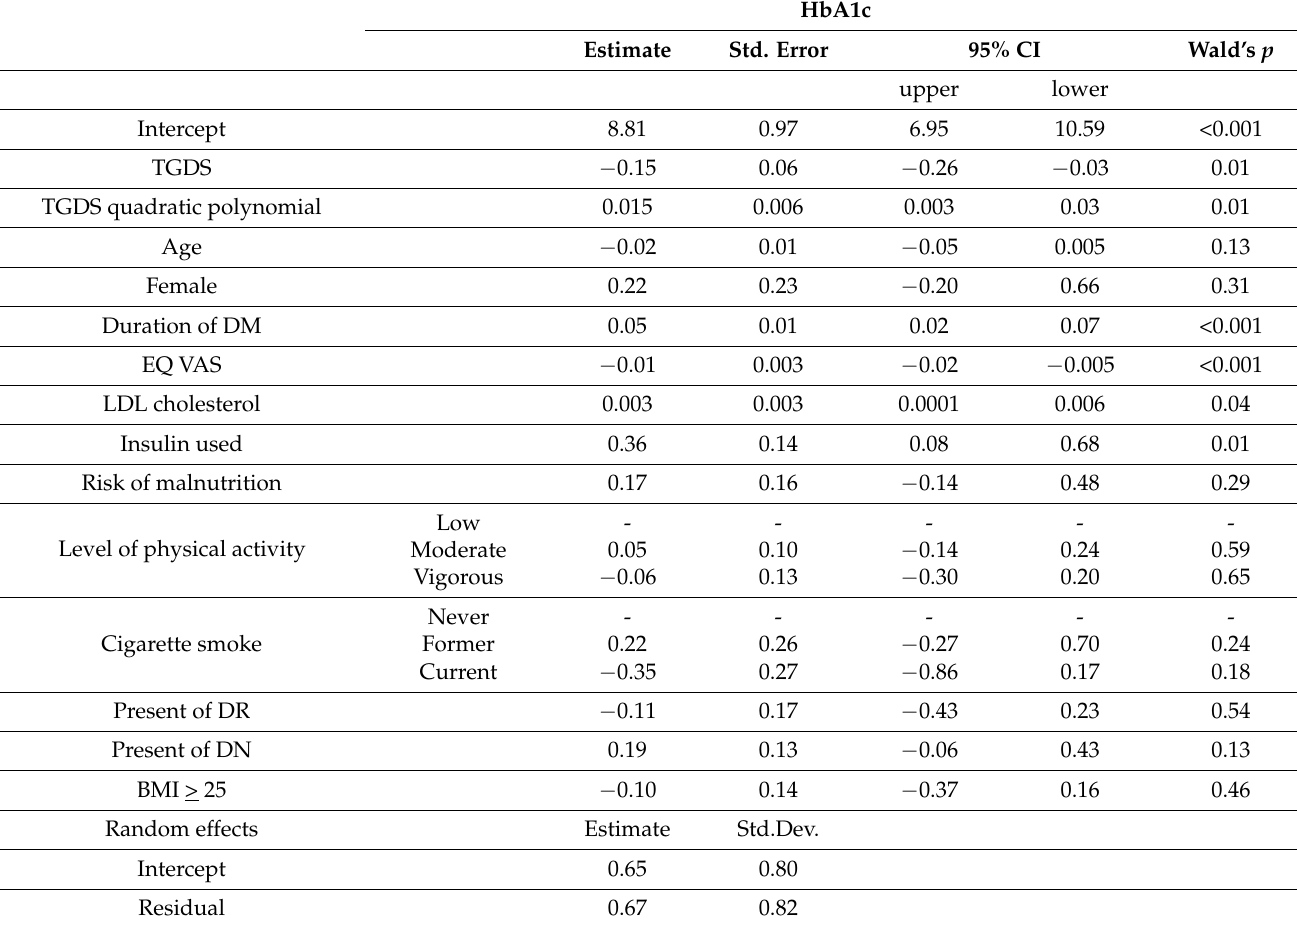
Table 2. Model-fitting result of the prospective analysis of depression as a predictor to glycemic control, controlling for covariates (fixed effects) and adjusted for within-person change over time (random effect), number of observations = 577. HbA1c Estimate Std. Error 95% CI Wald’s p upper